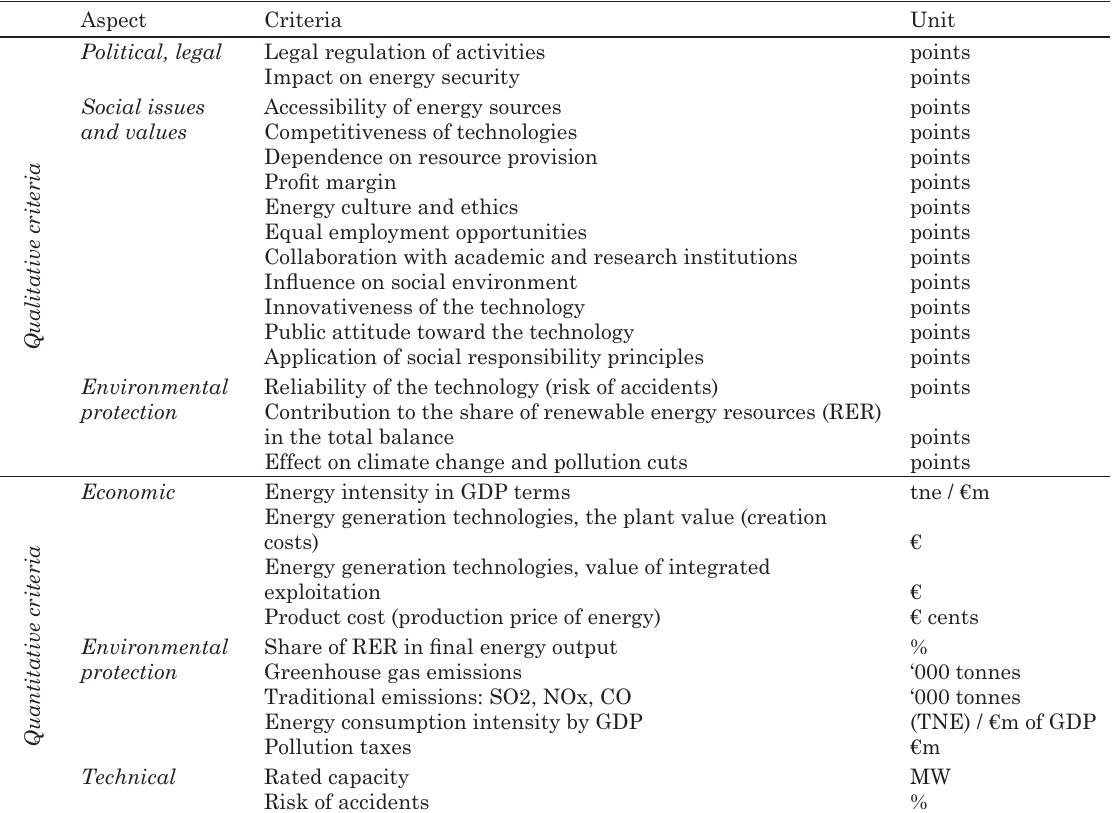
Table 1. assessment criteria of energy generation technologies